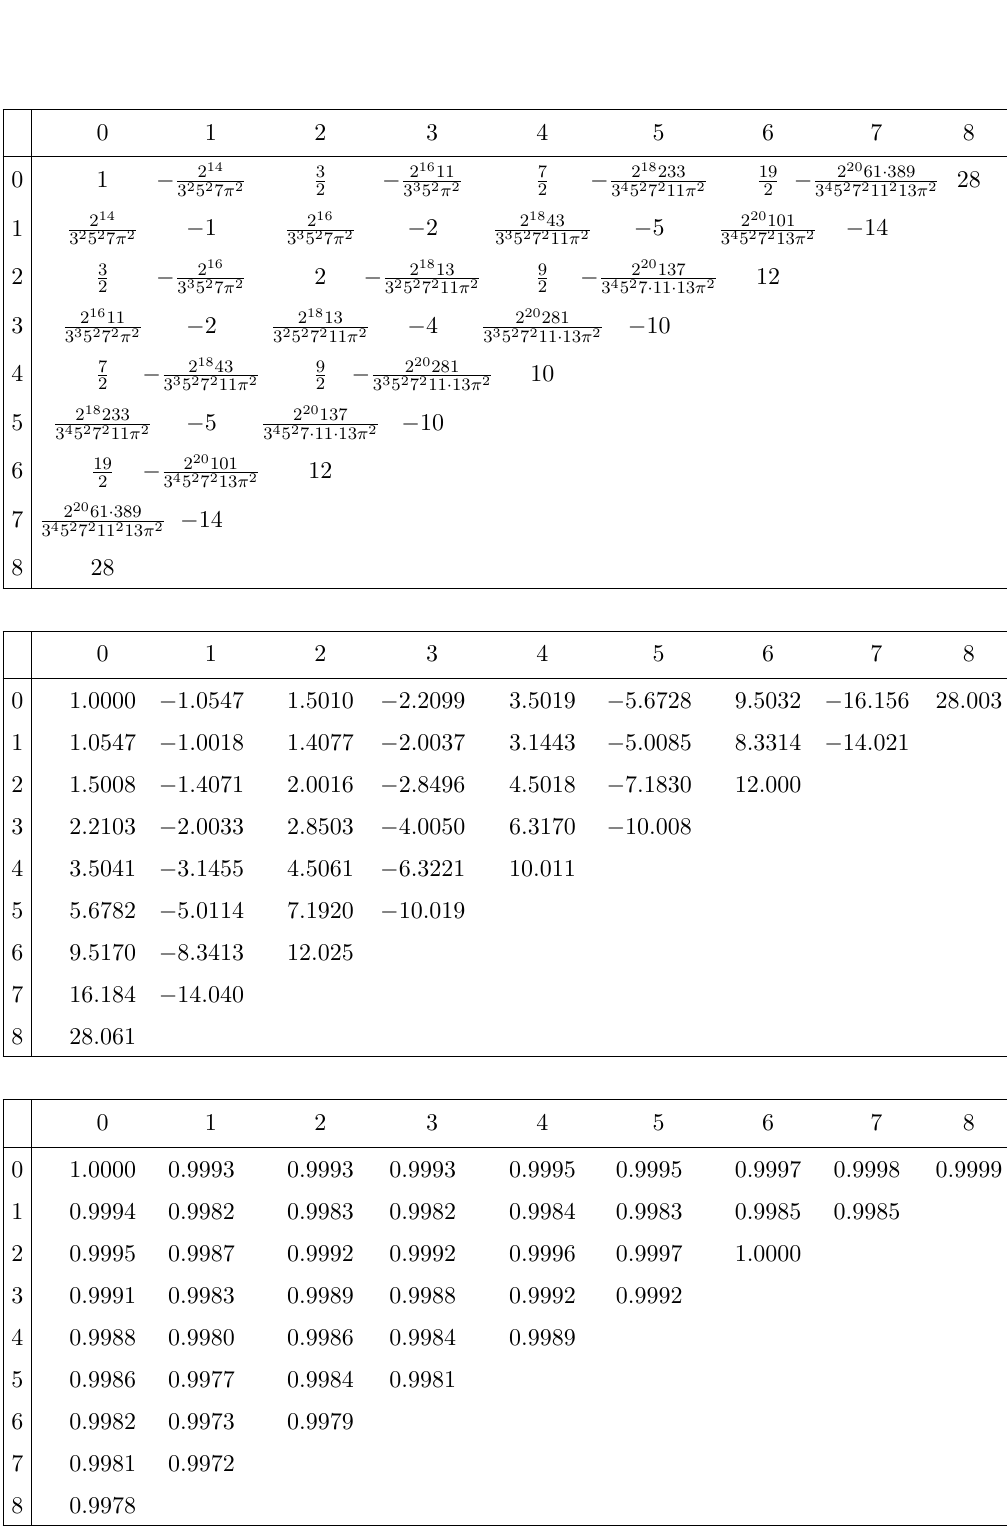
Table 14 . The (cid:12)rst table gives the moments h ~ (cid:11) m ~ (cid:12) n i for m + n (cid:20) 8, calculated from the distribution function (B.5). The second table gives the same moments calculated from the data of [28]. The third table gives the result of dividing the entries of the (cid:12)rst table by the corresponding entries of the second. For the cases shown, these ratios di(cid:11)er from unity by less than 3 parts per thousand.